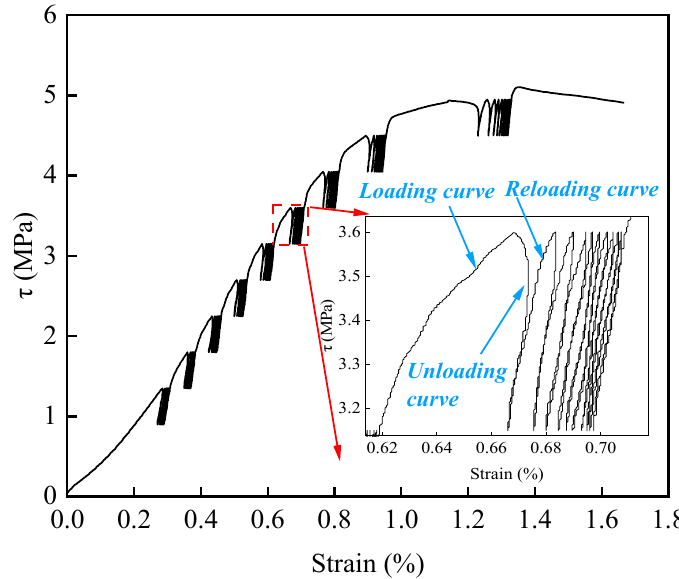
Figure 4. Stress–strain curves of specimen 4–6.52.